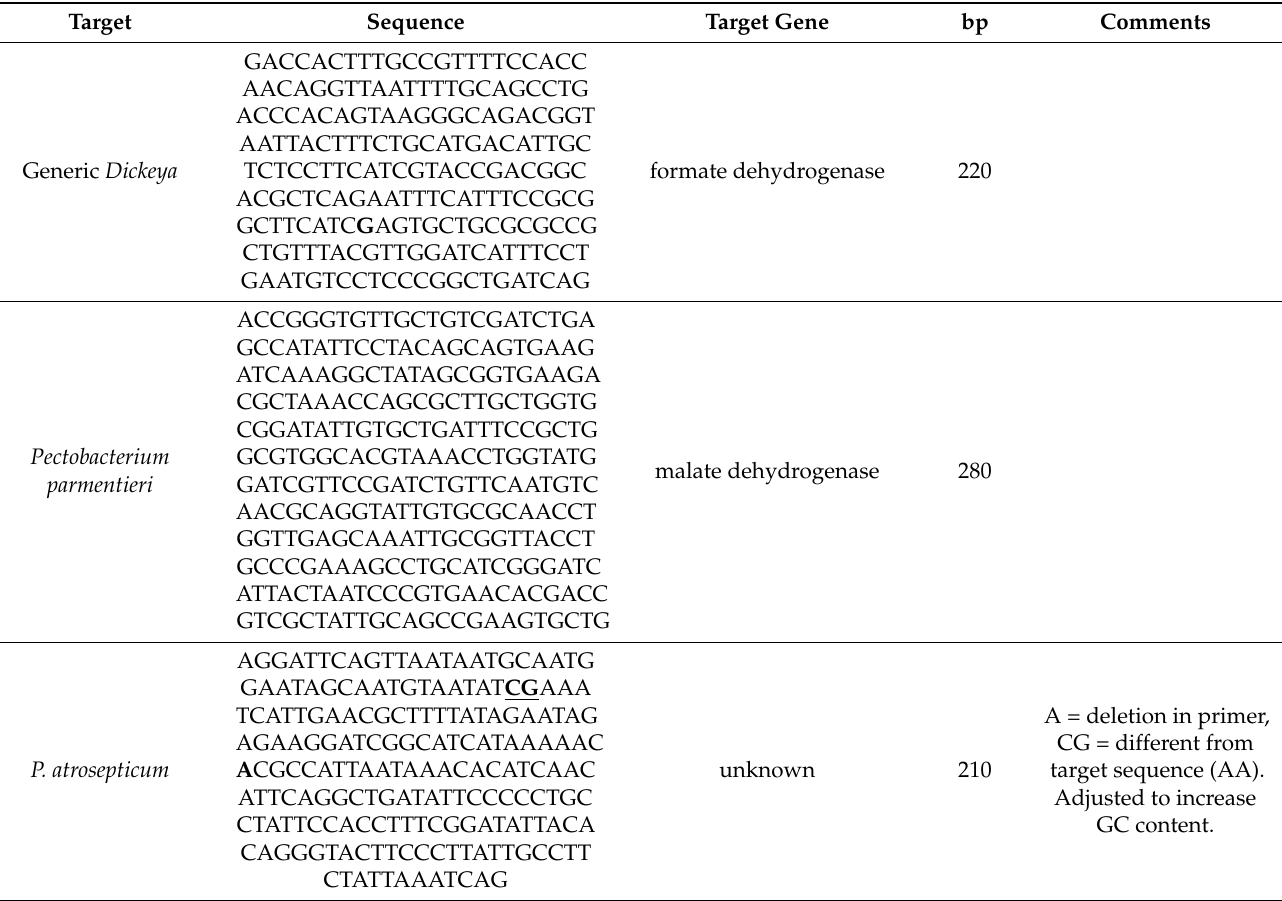
Table 3. Gblocks were used in this